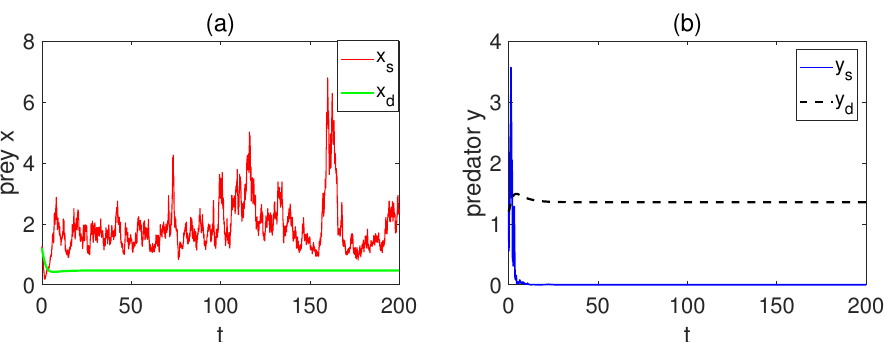
Figure 2. ( a , b ) The paths of prey x ( t ) and predator y ( t )